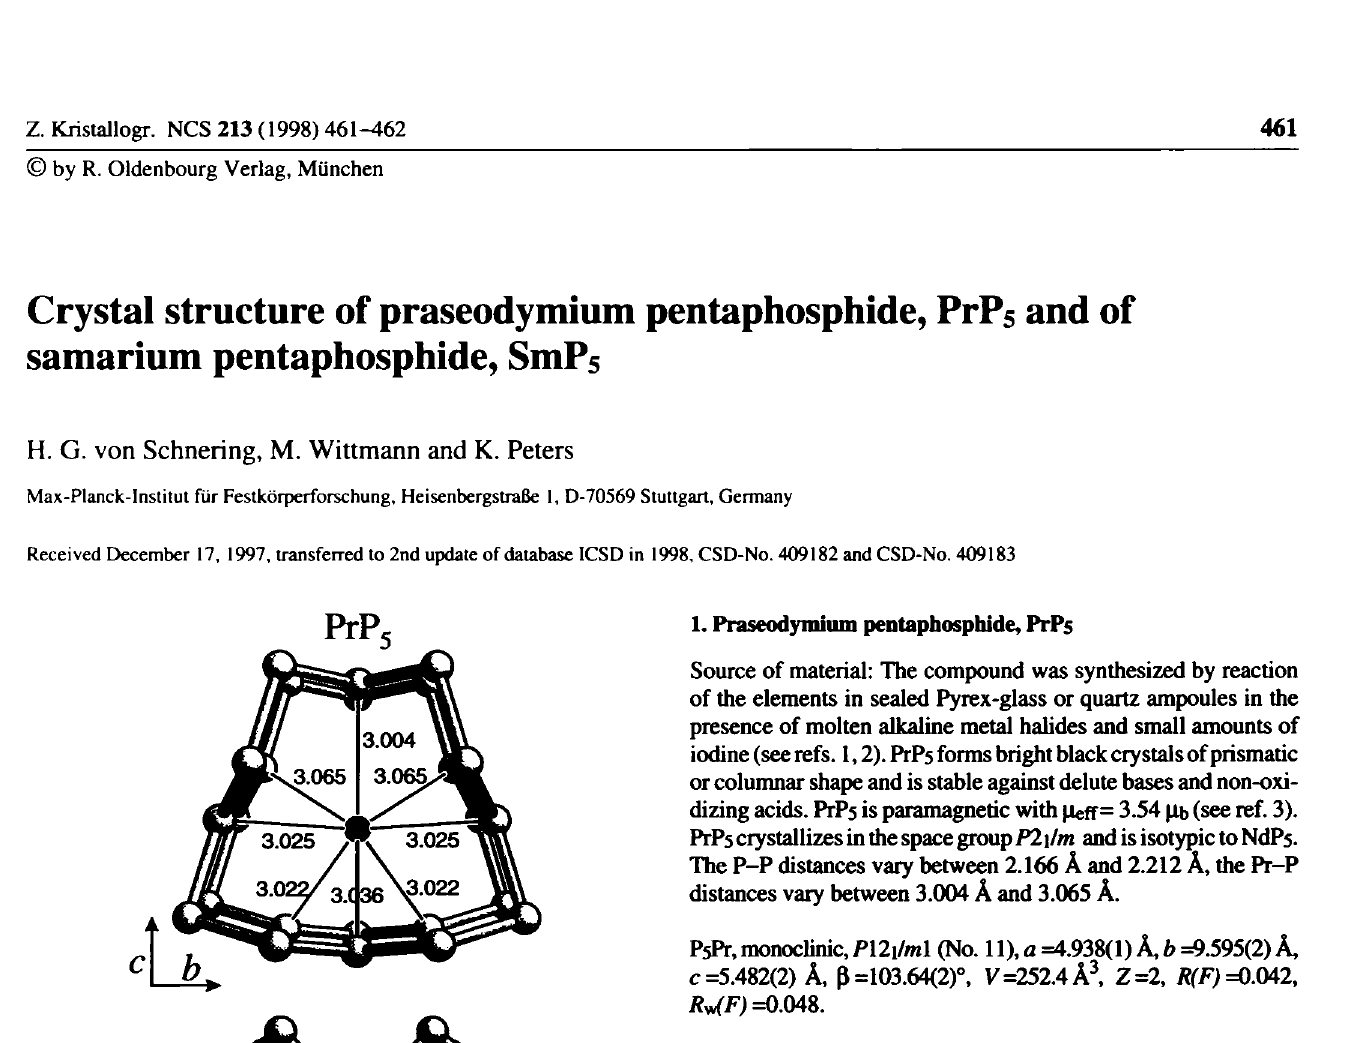
Table 1. Parameters used for the X-ray data collection Crystal: black, spherical, metallic luster, size 0.1 mm Wavelength: